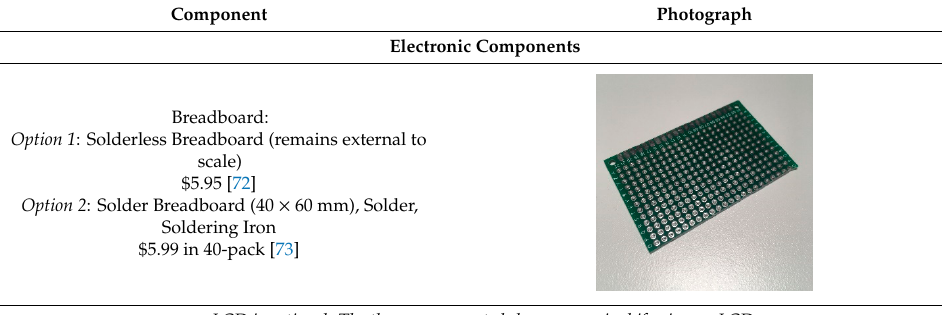
Component Photograph Electronic